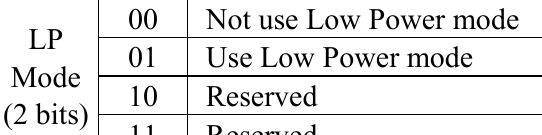
Table 5. LP mode.